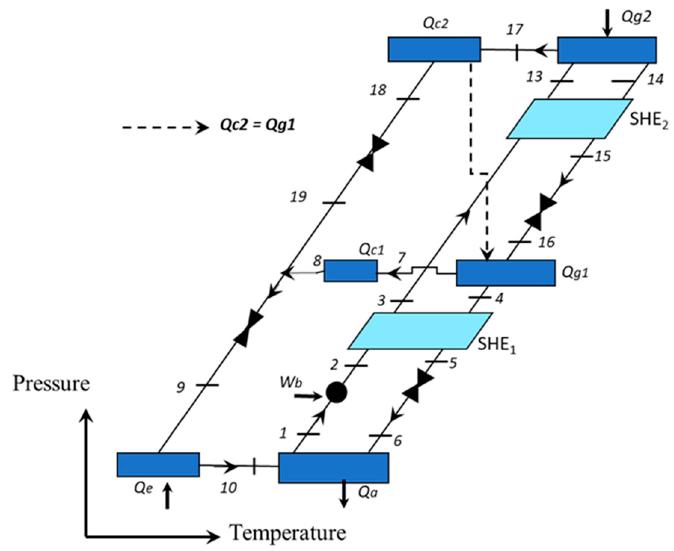
Figure 3. Schematic diagram for a double-effect absorption cooling system.